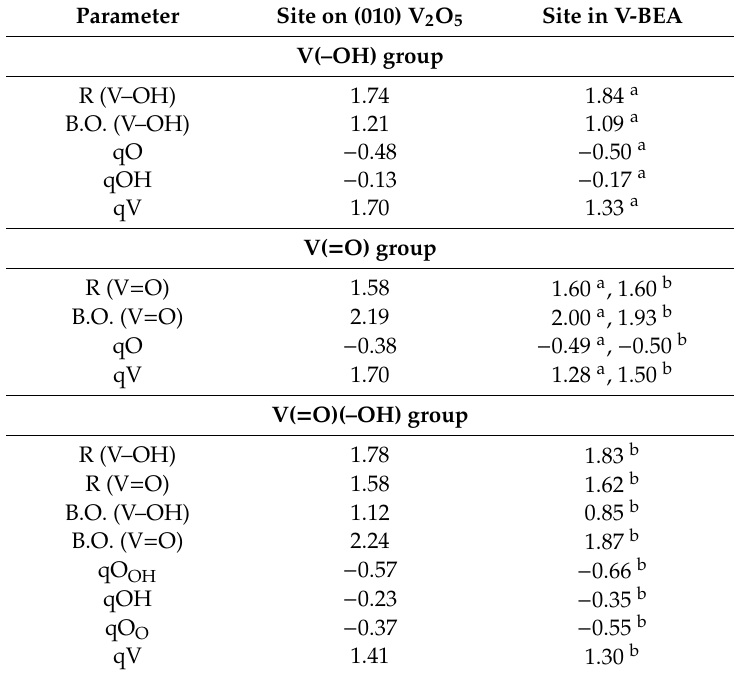
Table 5. Structural parameters of the investigated vanadium groups present on the (010) V 2 O 5 and introduced to most stable crystallographic positions in BEA zeolite ( a T2 site, b T3 site). O O denotes vanadyl oxygen, O OH denotes oxygen from hydroxyl.